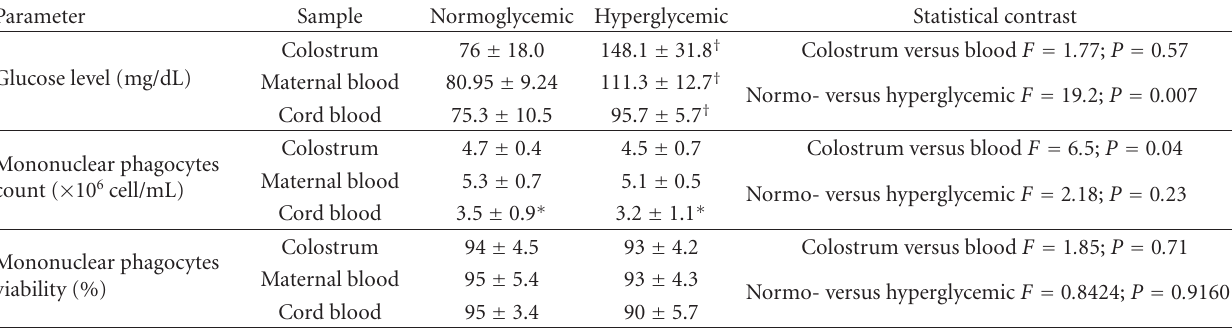
Table 1: Mean ( ± SD) glucose level, leukocyte count, and viability in colostrum, maternal blood, and cord blood from normoglycemic and hyperglycemic women.